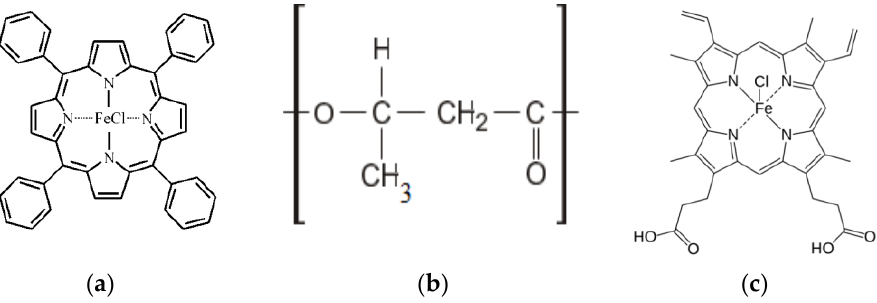
Figure 1. Structural formulas of ( a ) Fe(TPP)Cl, ( b ) PHB, and ( c )